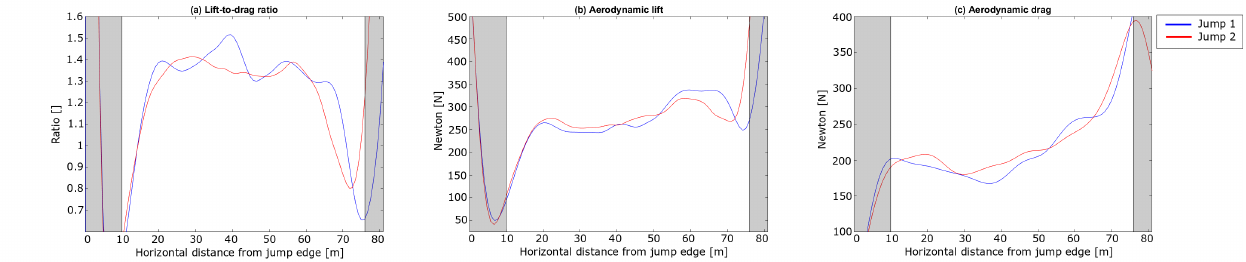
Figure 15. Forces acting on the ski jumper in the flight phase. ( a ) shows the lift-to-drag ratio ( F L / F D ), ( b ) the aerodynamic lift ( F L ) and ( c ) the aerodynamic drag ( F D ). The horizontal length from the in-run edge is shown on the x-axis with a unit less ratio in ( a ) and the forces [N] in ( b , c ) on the vertical axis. The gray shaded areas highlight the take-off and landing